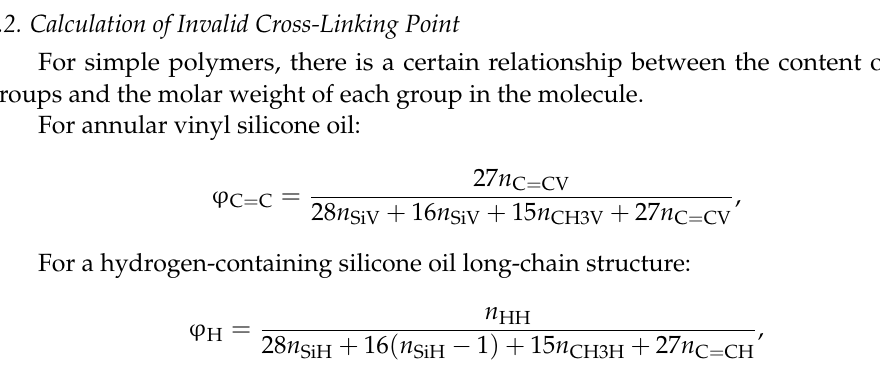
Figure 1. Flow of model and calculation of α value.